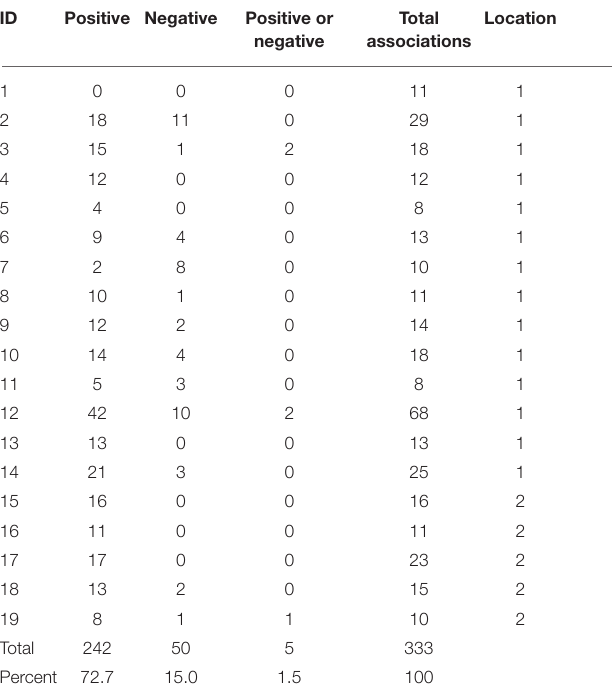
TABLE 4 | Evaluation of Urban